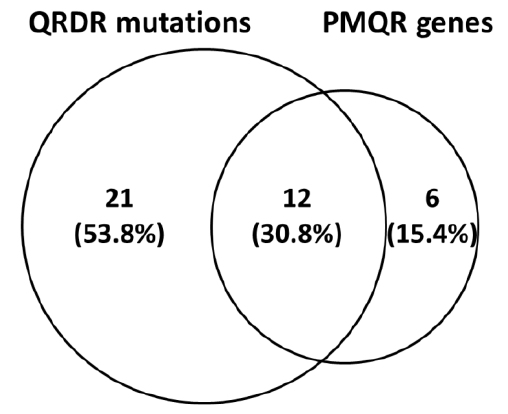
Figure 1. Venn diaphragm of QRDR mutations and PRQR genes in the 39 CIP-nonsusceptible NTS isolates.